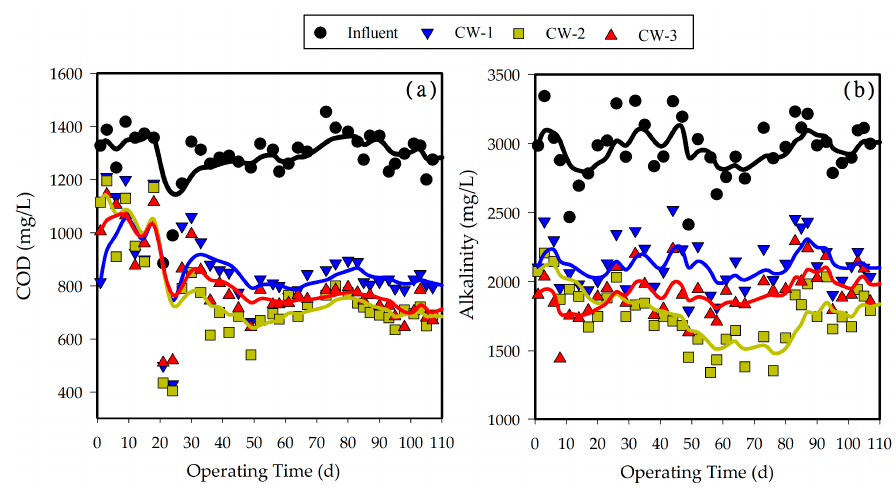
Figure 3. Dynamics of the concentration of COD and alkalinity in influent and effluent. ( a ) COD; and ( b ) alkalinity.